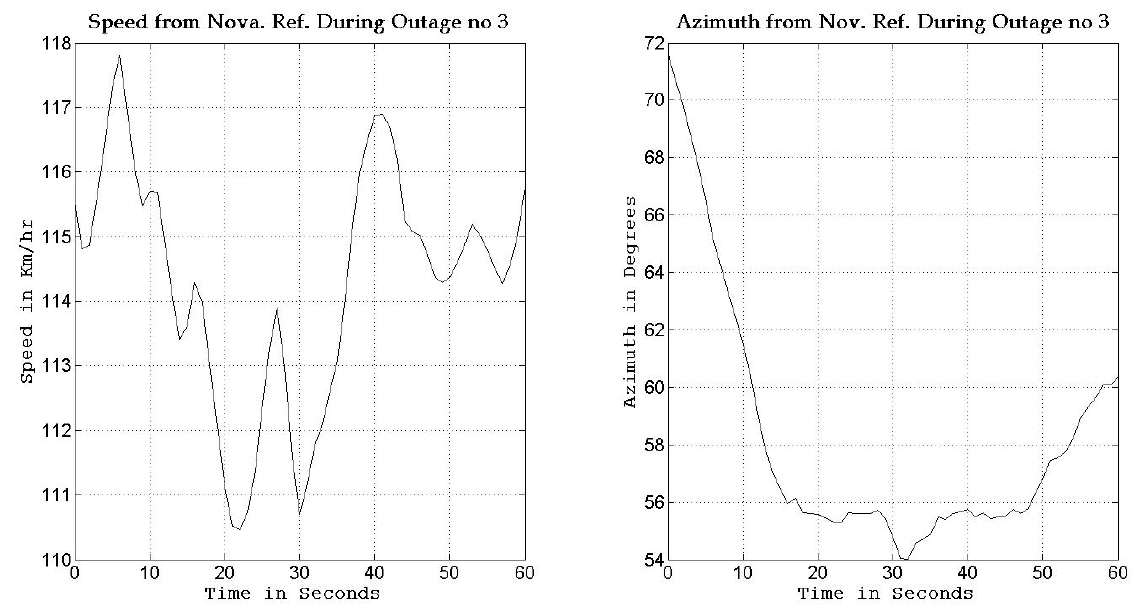
Figure 16. Forward speed and azimuth from Novatel reference during GPS outage #3 of the second